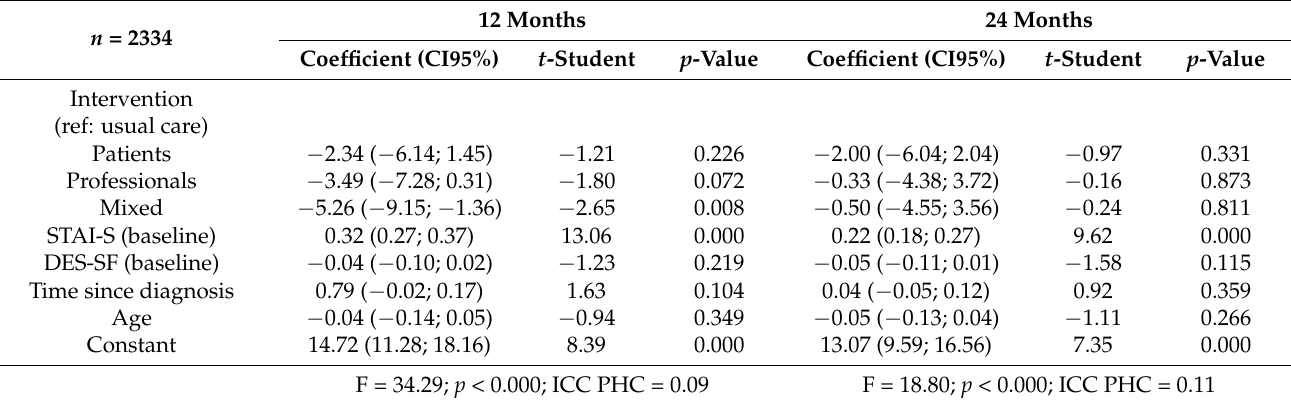
Table 3. Regression model for state-anxiety (STAI-S) after 12 and 24 months.